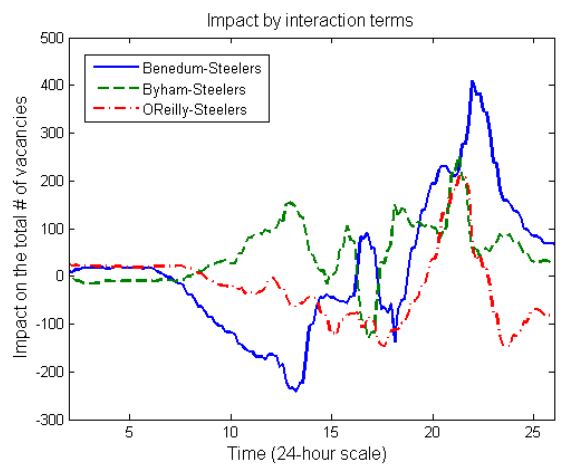
Figure 7. Impact of interaction terms that involved Steelers’ night game.